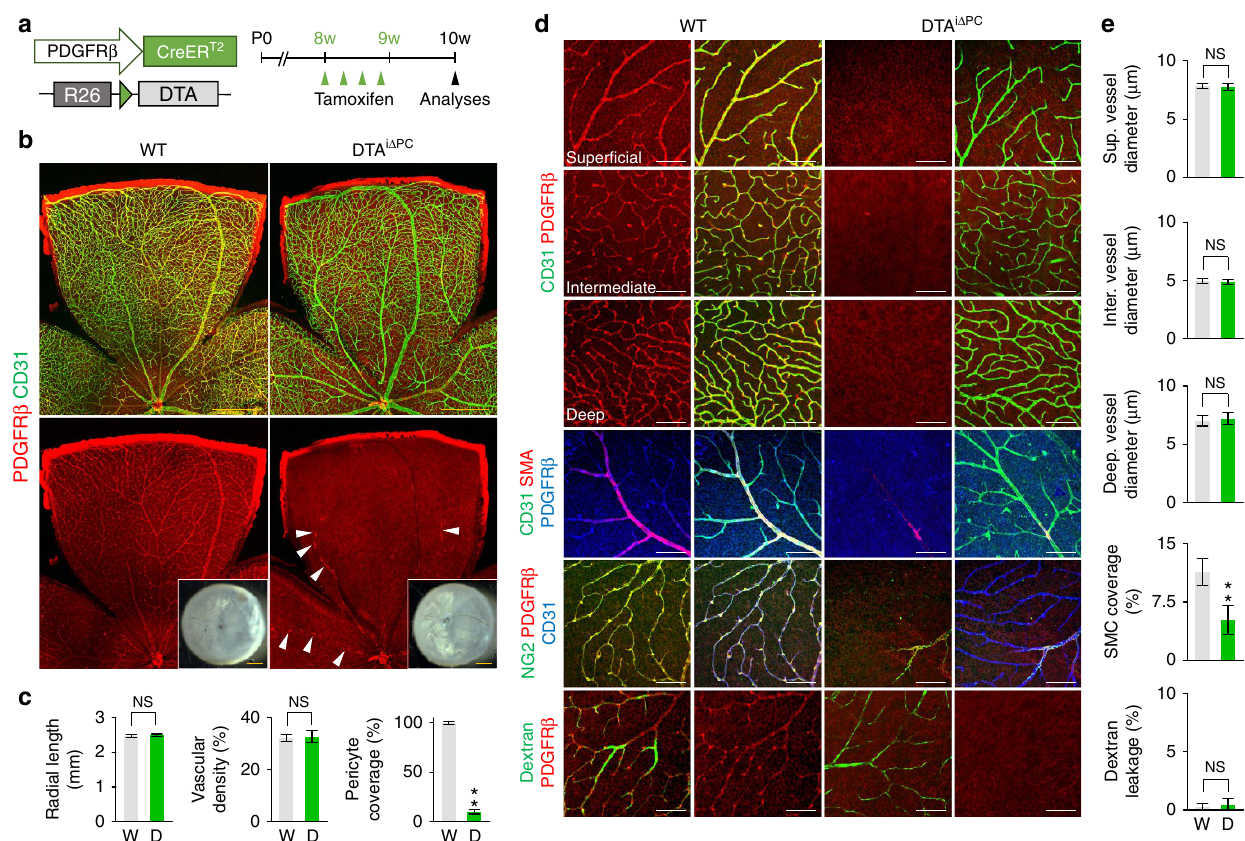
Figure 8 | Pericyte-free retinal vessels of adults are resistant to vascular leakage. ( a ) Diagram depicting the experiment schedule for selective loss of pericytes in retinal vessels of 8-week-old mice and their analyses at 2 weeks later using DTA i D PC mice. ( b ) Images of CD31 þ vessels and PDGFR b þ pericyte coverage in WT and DTA i D PC mice. Only a small number of pericytes (arrowheads) remained in retinal arteries of DTA i D PC mice. Right lower panels, no visible hemorrhage is found in inner surface of retinal cups in both mice. ( c ) Comparisons of indicated parameters in WT (W; n ¼ 6) and DTA i D PC (D; n ¼ 6) mice. ( d , e ) Images and comparisons of CD31 þ vessels and PDGFR b þ pericyte coverage in three layers, SMA þ SMCs surrounding arteries, NG2 þ pericyte coverage, and dextran (70kDa) leakage in retinas in WT (W, n ¼ 6) and DTA i D PC (D, n ¼ 6) mice. Error bars represent mean ± s.d. ** P o 0.01 versus WT by Mann–Whitney U test. NS, non-significant. Scale bars, 100 m m (white) and 500 m m